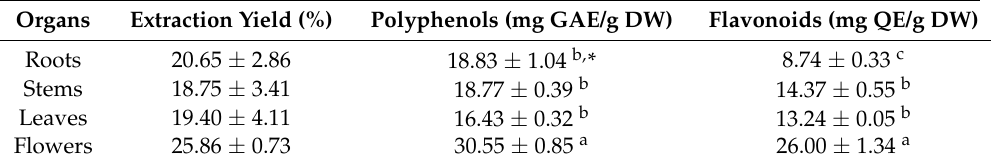
Table 1. Extraction yield, polyphenol, and flavonoid contents in methanolic extracts of Cladanthus mixtus .